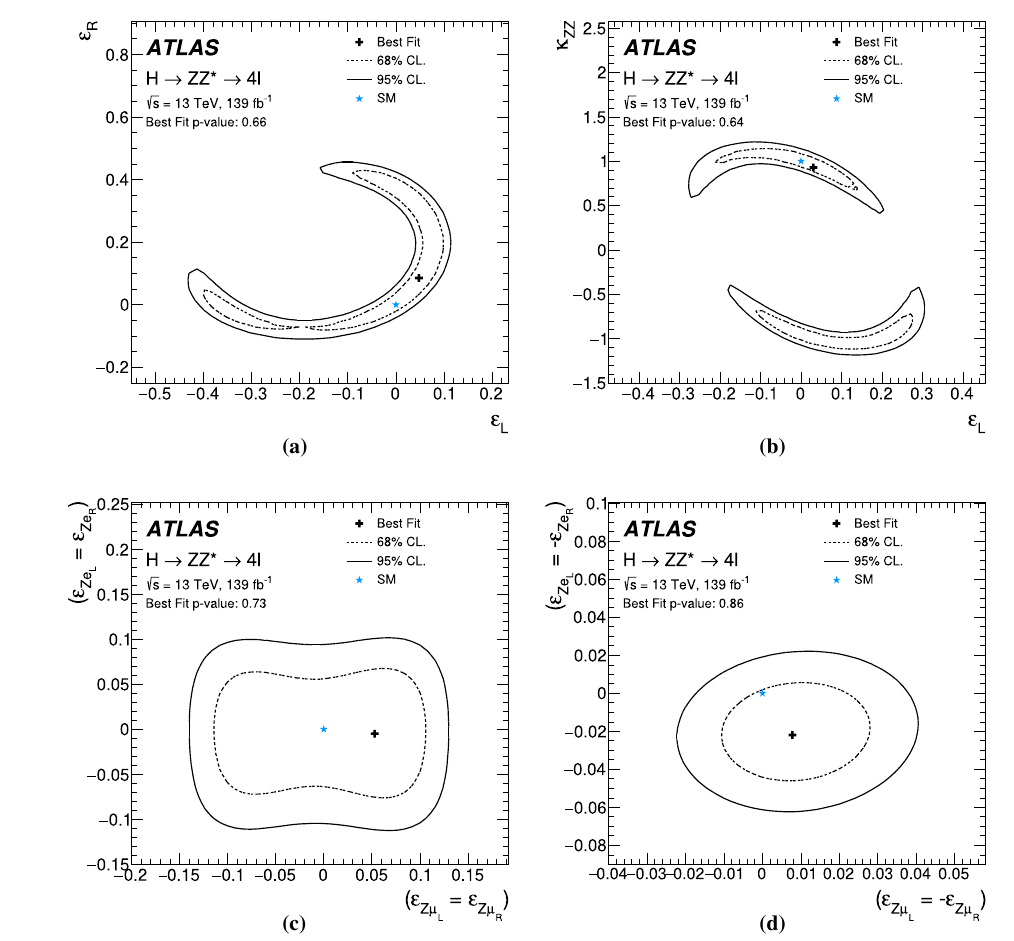
Fig. 40 Observed limits at 68% and 95% CL on the modified Higgs bosondecayswithintheframeworkofthepseudo-observables: a flavour universal contact terms; b linear EFT-inspired; c flavour non-universal vectorcontactterms; d flavournon-universalaxial-vectorcontactterms. The p values shown represent the probability of compatibility between